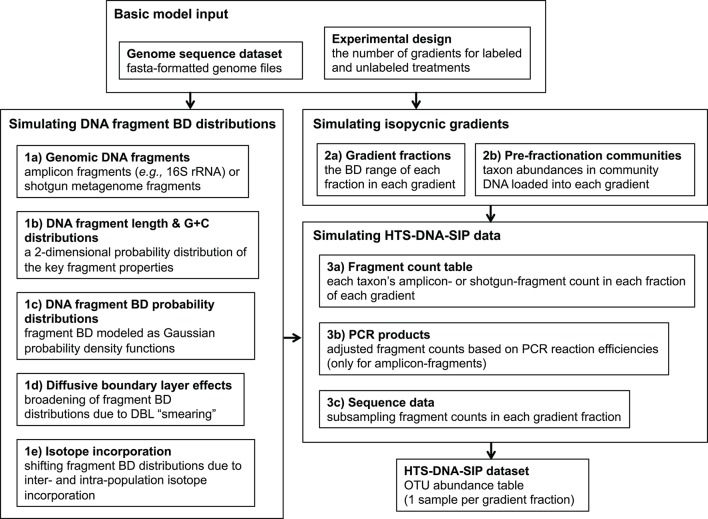
The SIPSim simulation workflow involves three major stages, which are broken down into multiple steps. Stage 1 involves generating a buoyant density distribution of gDNA fragments for each genome. Stage 2 involves simulating the isopycnic gradients for a particular experimental design. Stage 3 involves generating a DNA-SIP dataset based on the fragment BD value distributions simulated in Stage 1 along with the isopycnic gradient data generated in Stage 2. The output is a table (“DNA-SIP dataset”) of taxon relative abundances in each gradient fraction in each gradient. See section Methods for a more detailed description of the simulation workflow.